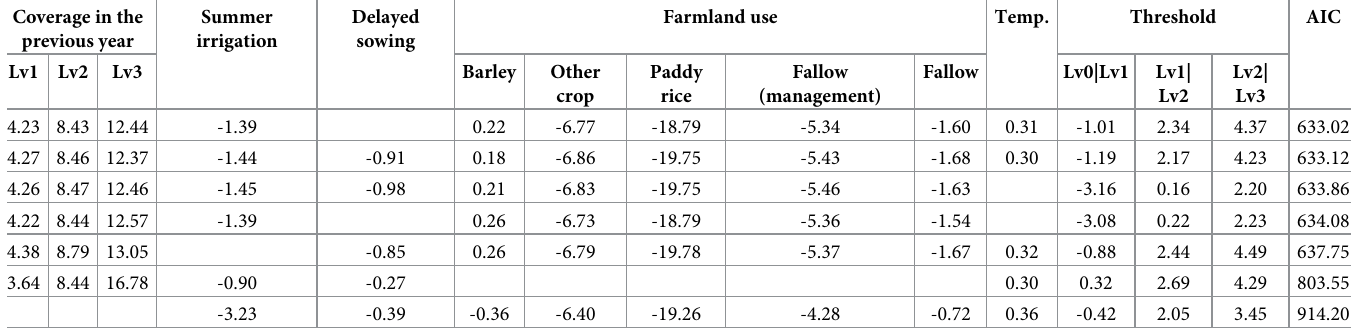
Table 2. Coefficients and AIC values of the mixed ordinal logistic regression models showing the effects of coverage in the previous year, summer irrigation, delayed sowing, farmland use, and temperature on coverage levels of Avena fatua . Coverage in the Summer Delayed Farmland use previous year irrigation sowing